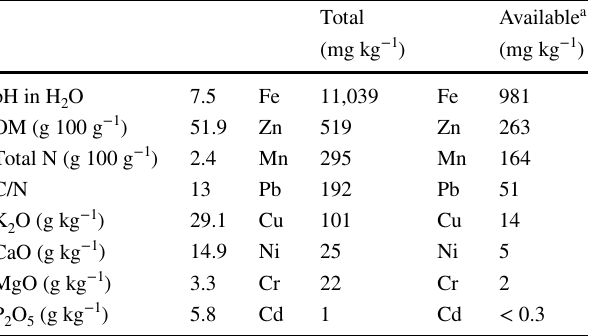
Table 2 Characteristics of the compost